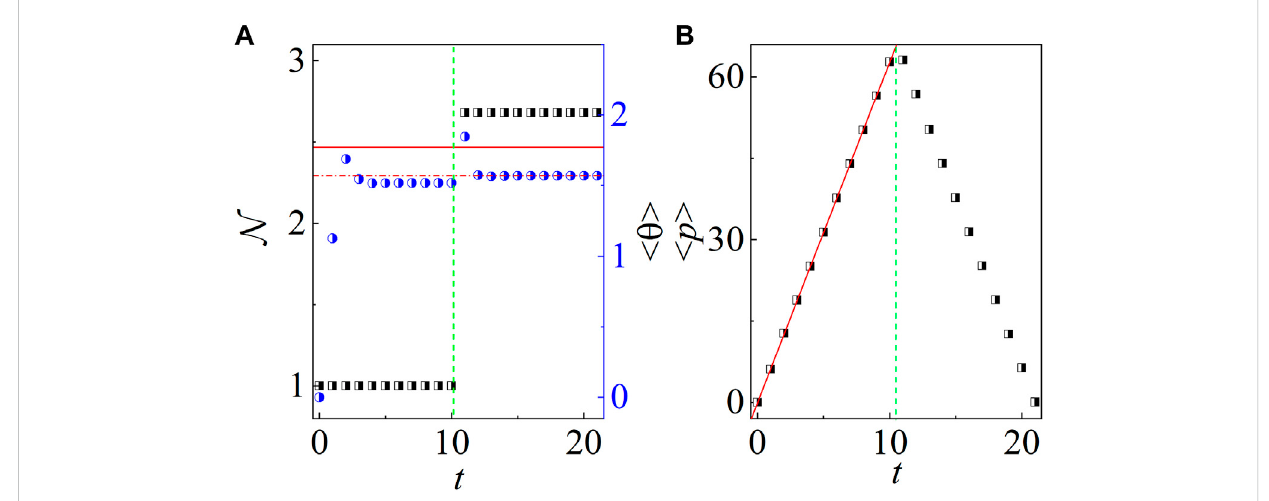
FIGURE 4 Distributionsinreal(leftpanels)andmomentum(rightpanels)space.In (A – D) ,blackandredlinesindicatethedistributionofthestatesattheforward | ψ ( t j ) 〉 and backward | ψ R ( t j ) 〉 evolution, respectively, with t = t 0 (top panels), t = t 5 (middle panels), and t = t 10 (bottom panels). In (E – F) , red and black lines indicatethedistributionofthestates| ψ ( t 10 ) 〉 and | ~ ψ ( t 10 ) 〉 (cid:1) θ | ψ ( t 10 ) 〉 .Bluedashedlinesindicatethepower-lawdecay | ψ | 2 ∝ ( p − p c ) − 2 .Theparametersare the same as in Figure